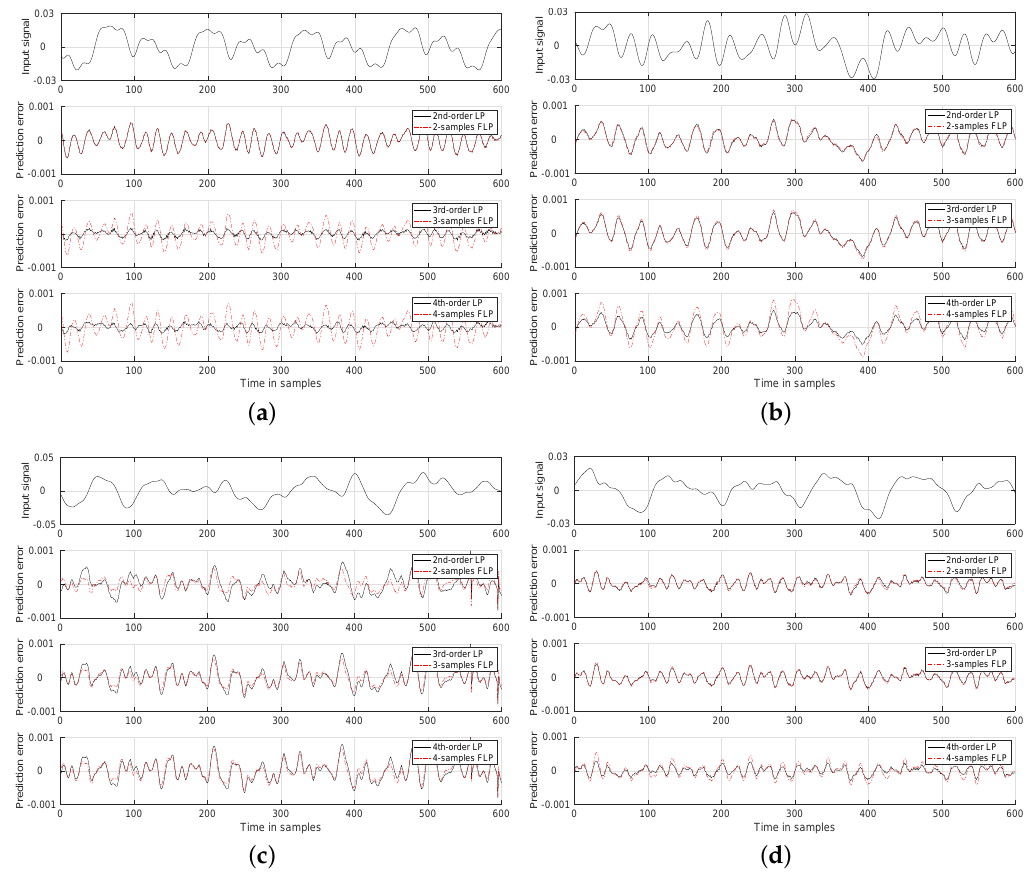
Figure 3. The prediction error results for the musical signals (MAPS–MUS) for second-order, third-order and fourth-order LP and the FLP with the two-sample, three-sample, and four-sample memory: ( a ) studio recording; ( b ) jazz club recording; ( c ) church recording; and ( d ) concert hall recording.